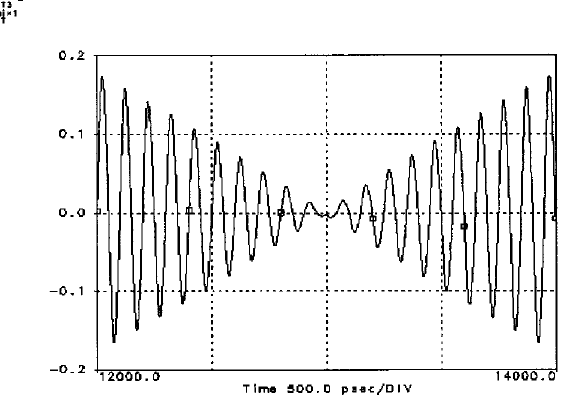
FIGURE 21 BPSK wave during a time slot around the moment that input signal changes.